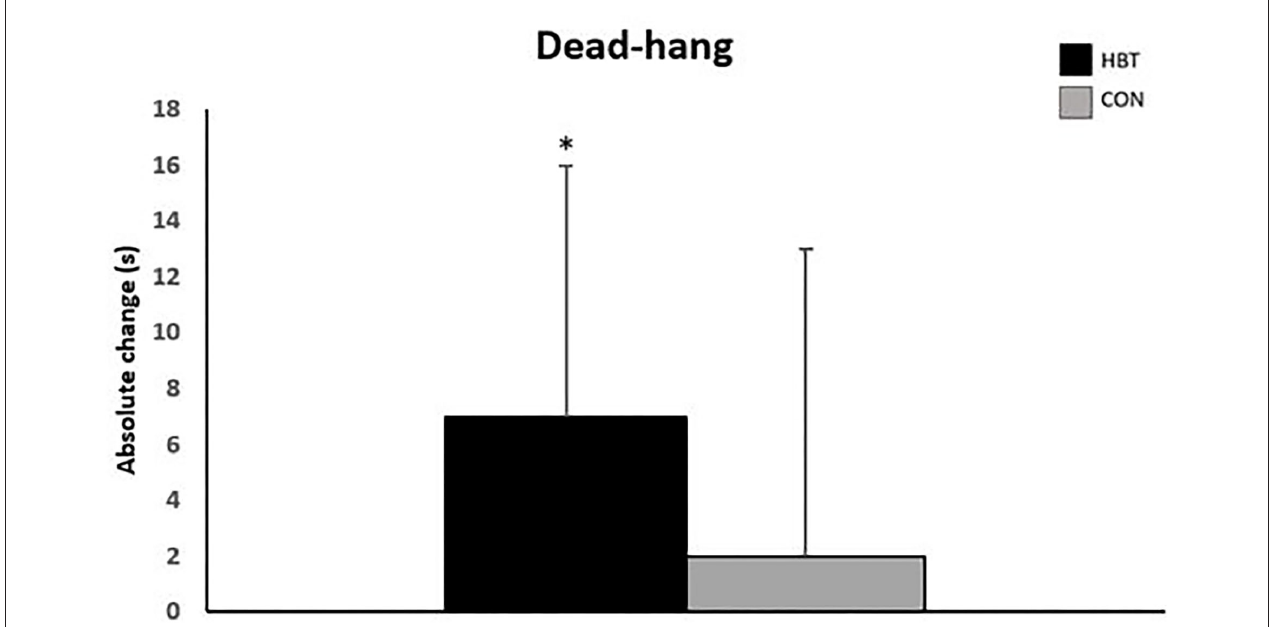
FIGURE 3 | Absolute change (in seconds) for Dead-hang test. *Significant change from pre-test ( p < 0.05).